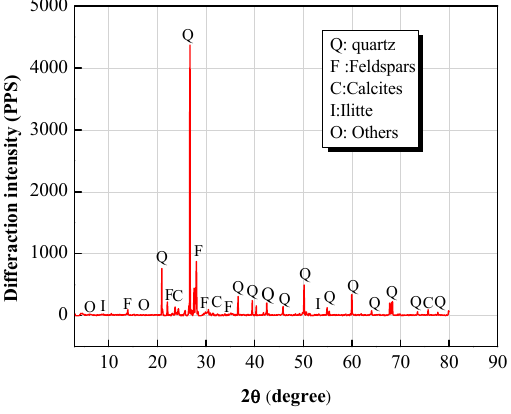
Figure 2. Particle size distribution of AS.